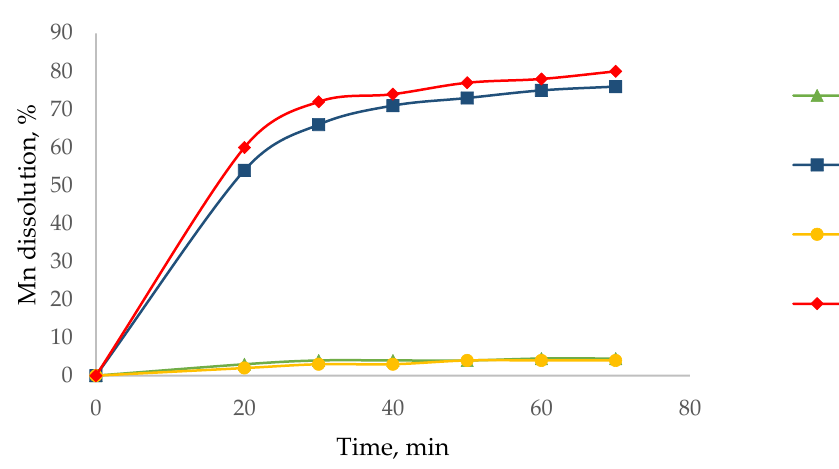
Figure 2. Dissolution of Mn from a black copper ore.